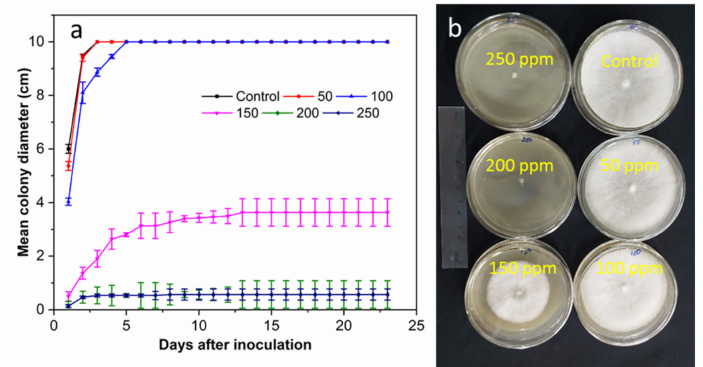
Figure 5. ( a ) The antifungal activity of SCNs at different concentrations against L. pseudotheobromae incubated at 28 ◦ C for 23 days and ( b ) plates incubated for 3 days.